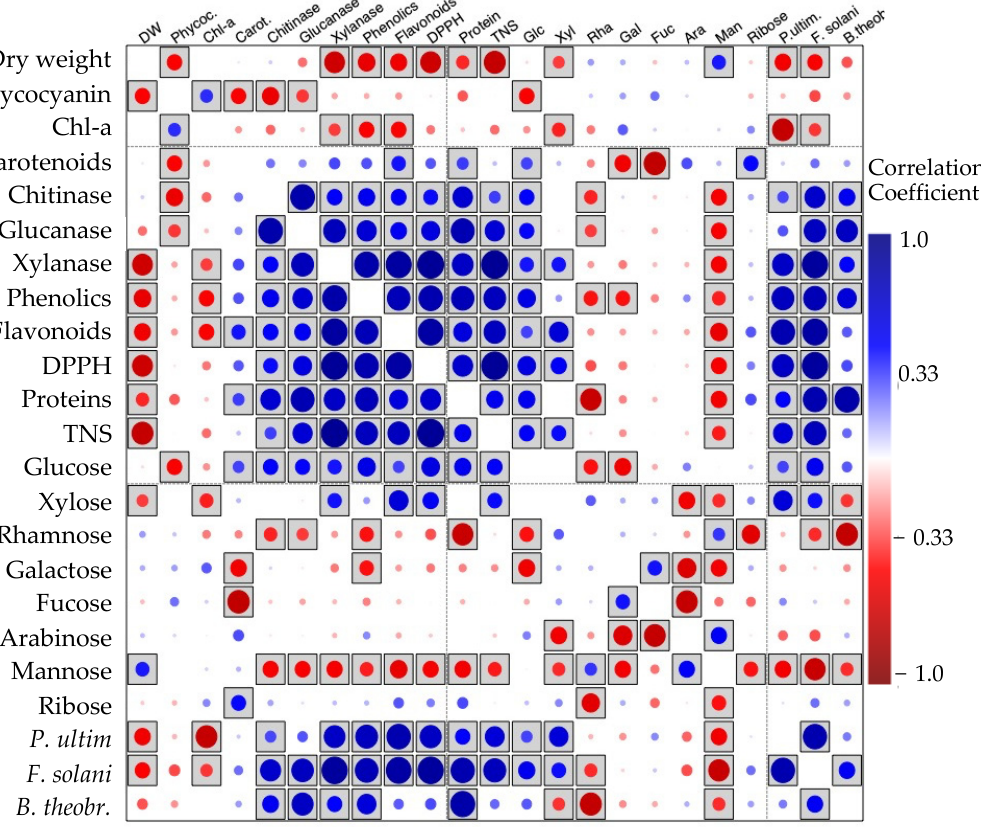
Figure 8. Pearson’s correlation matrix represents the interrelationships between variables. The correlation was followed by a two-tailed significance test at the 0.05 level. Blue indicates a positive correlation, red for negative correlation, and boxed colors for significant correlation. Circle colors correspond to the correlation coefficient.